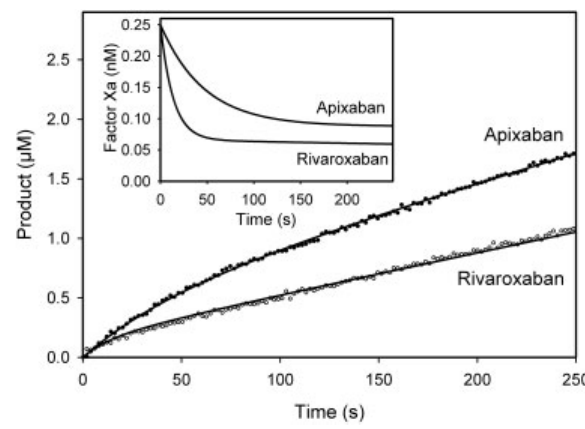
Fig. 3 Comparison of the effects of rivaroxaban and apixaban on factor Xa chromogenic activity. Inhibition constants (K i ) were deter- mined by incubating 5 nM factor Xa with rivaroxaban ( open ) or apixaban ( closed ) at the indicated concentrations, and residual active factor Xa concentration was determined by monitoring hydrolysis of 500 μ M S-2765. Symbols re fl ect the mean (cid:3) SD of three to four experiments. Lines are fi t to a rectangular hyperbola equation by nonlinear regression analysis.